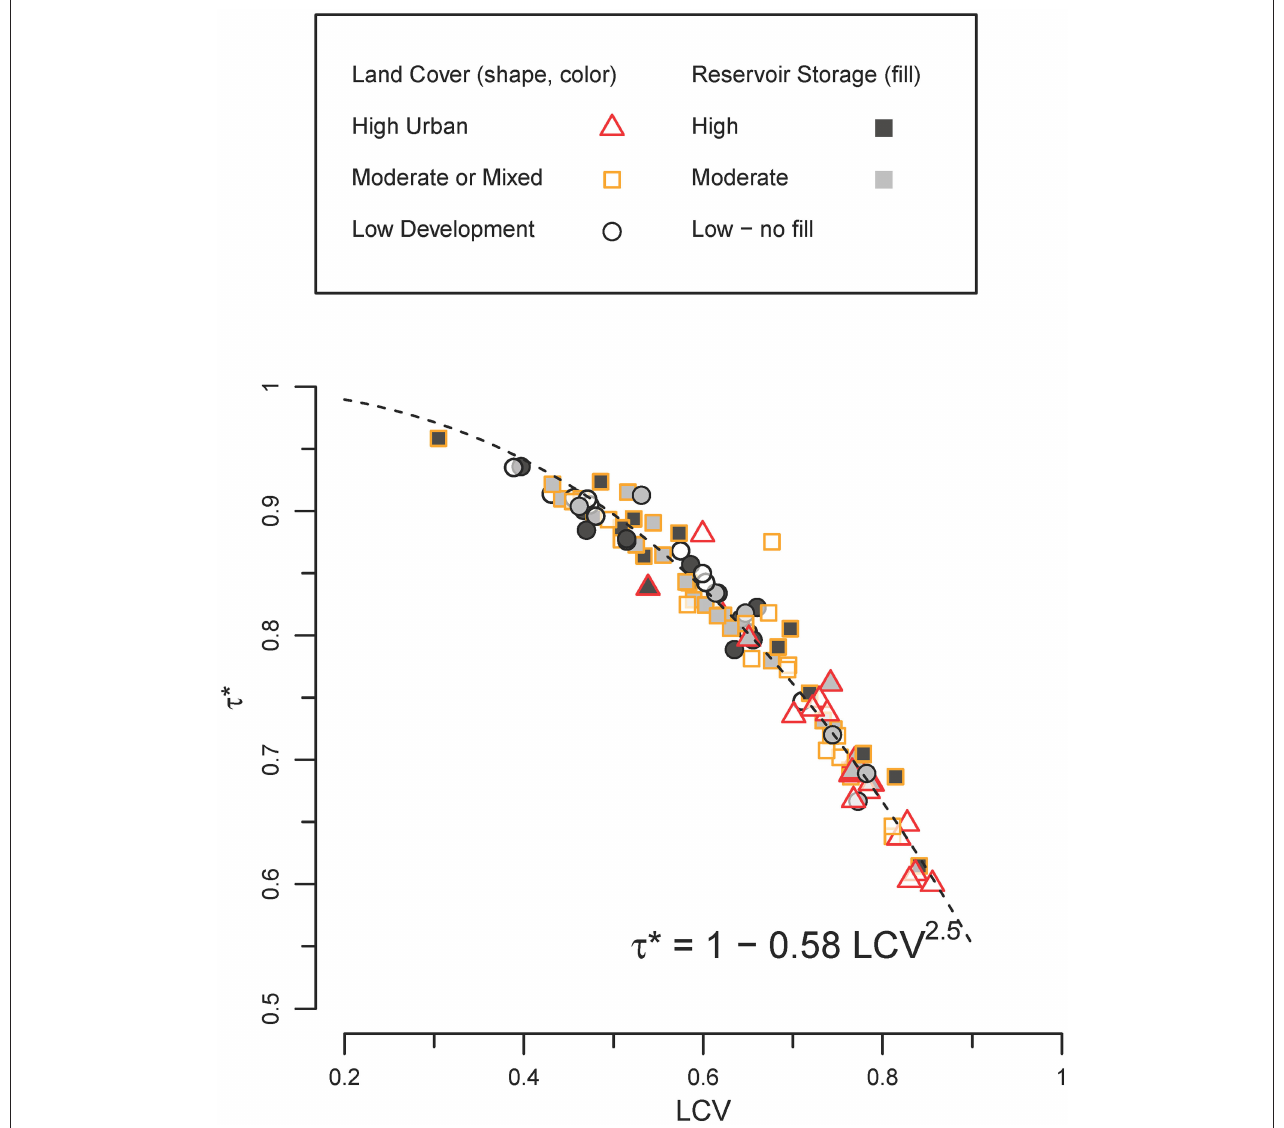
FIGURE 6 | Ratio of flow-weighted travel time to travel time of mean streamflow, τ *, in relation to linear coefficient of variation, LCV. Dashed line is τ * = 1–0.58 LCV 2.5